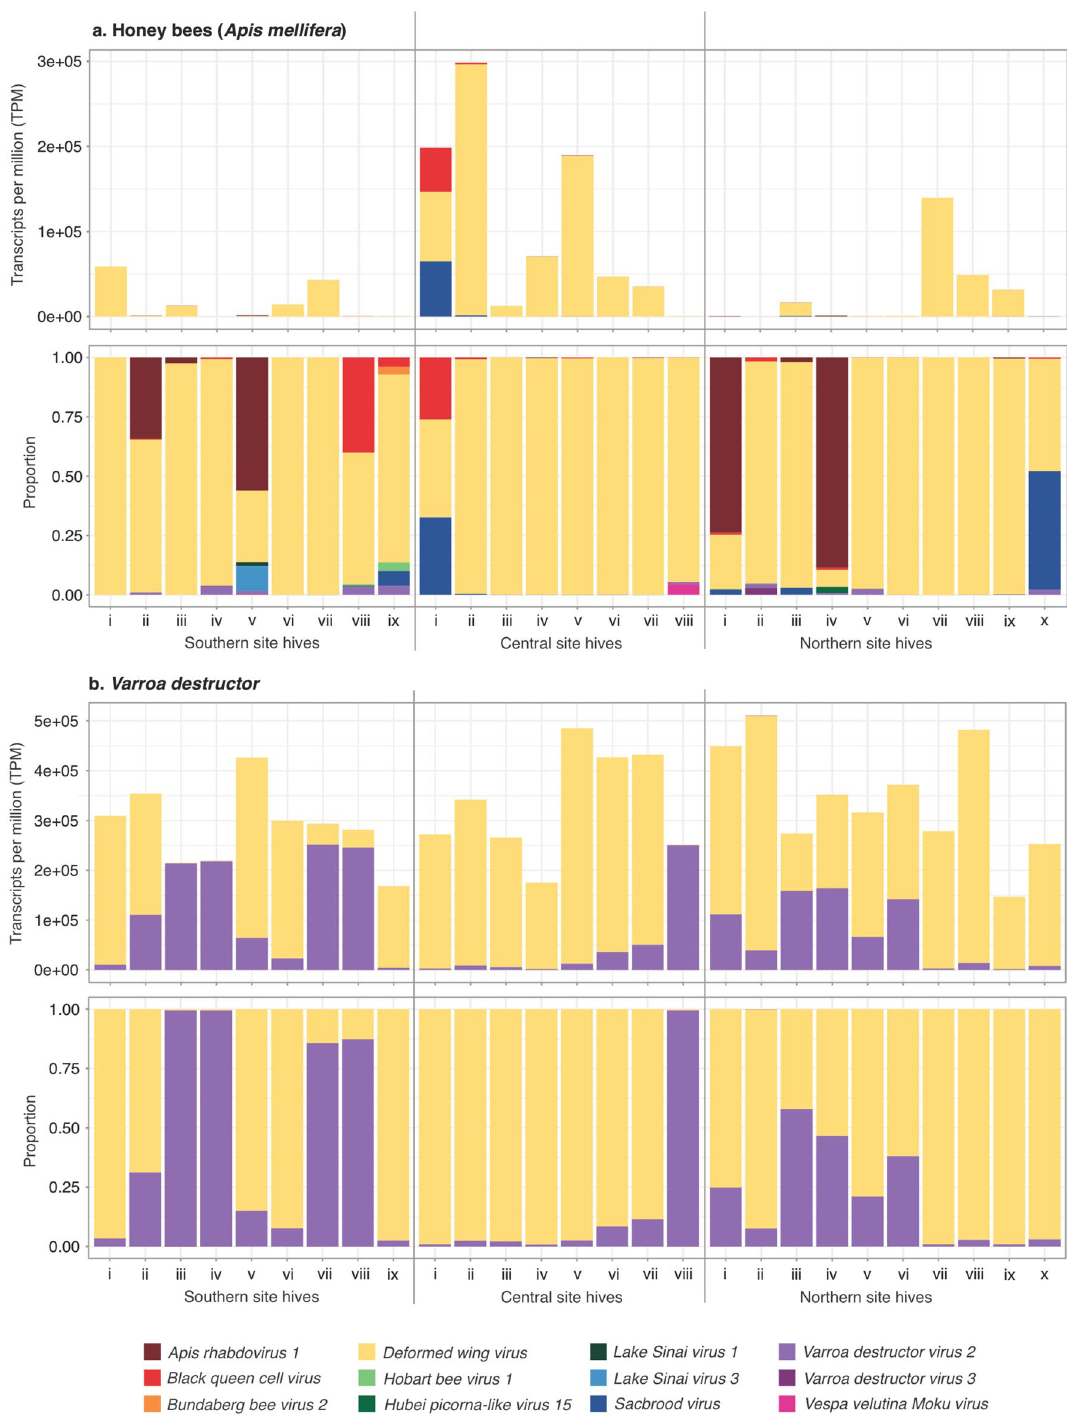
Figure 2. Viruses in honey bees and V. destructor mites. ( a ) DWV-A was the most abundant and prevalent in honey bees, occurring in all bee samples from all 27 hives that we sampled, although with substantial variation between samples. A total of 17 virus species were seen in these bee samples. ( b ) In comparison to the bees, the viral loads in mites showed much less variation. The viral community of V. destructor was dominated by DWV-A and VDV-2. Eight other viruses were observed in relatively low abundance from these